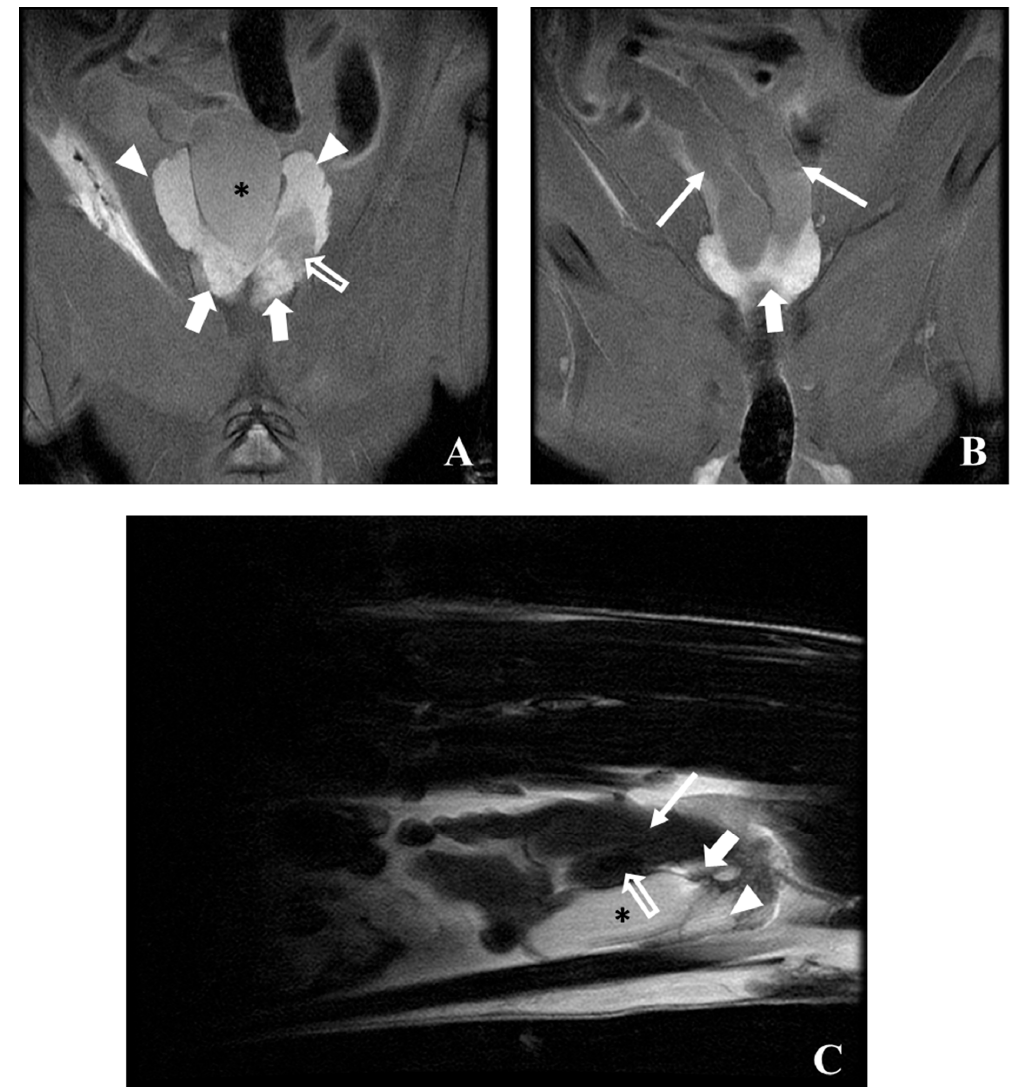
Figure 9. MRI PD weighted images of a cancer-induced animal, 58 weeks of age in dorsal ( A , B ) and sagittal ( C ) plane. The urinary bladder (asterisk) is well visible, surrounded by the dorsal (bold arrow) and ventral prostate (arrowhead), and the seminal vesicles (arrow). Low-intensity MRI signals were observed (open arrows) in transition dorsal / ventral prostate ( B ) and in seminal vesicles ( C ).